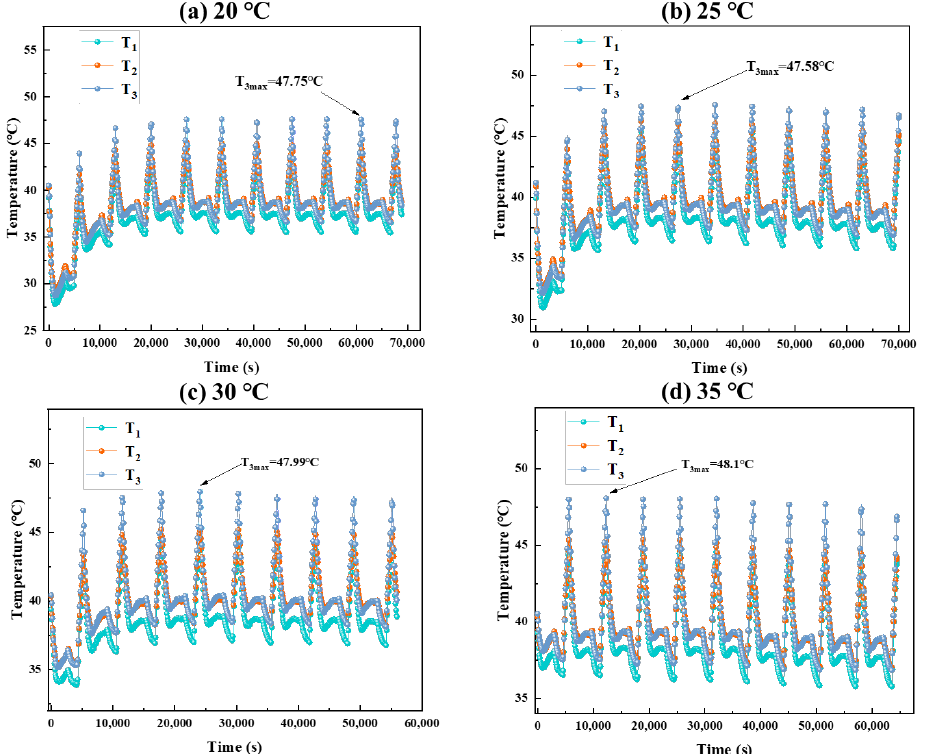
Figure 8. Temperature control performance of the CPCM-liquid module during 10 charge – dis- charge cycles adopting different inlet water temperatures of ( a ) 20 °C, ( b ) 25 °C, ( c ) 30 °C and ( d ) 35 ◦ C, ( b ) 25 ◦ C, ( c ) 30 ◦ C and ( d ) 35 ◦ °C. cycles adopting different inlet water temperatures of ( a ) 20